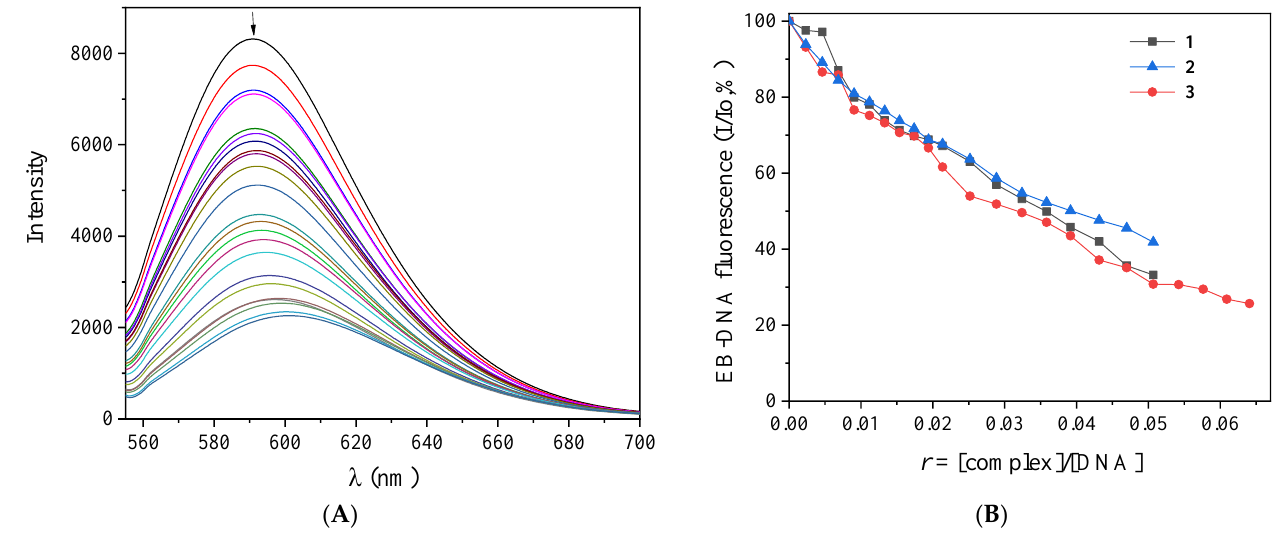
l ( n m ) Figure 9. ( A ) Fluorescence emission spectra (λ ex = 540 nm) of EB –DNA ([EB] = 20 μM, [DNA] = 26 μM) in buffer solution (150 -mM NaCl and 15-mM trisodium citrate at pH7.0) in the absence and presence of increasing amounts of complex 3 (different colors). The arrow shows the changes in intensity upon increasing amounts of 3 . ( B ) Plot of relative EB – DNA fluorescence intensity (I/Io, %) at λ em = 592 nm versus r (r = [complex]/[DNA]) in the presence of complexes 1 – 3 (up to 33.2% of the initial EB – DNA fluorescence for 1 , 41.8% for 2 , and 25.7% for 3 ). Table 9. Fluorescence features of the EB-displacement studies: percentage of EB – DNA fluorescence quenching (ΔI/Io, %), Stern– Volmer constants (K SV , in M −1 ), and quenching constants of the EB – DNA fluorescence (K q , in M −1 s −1 ) for complexes 1 – 3 .